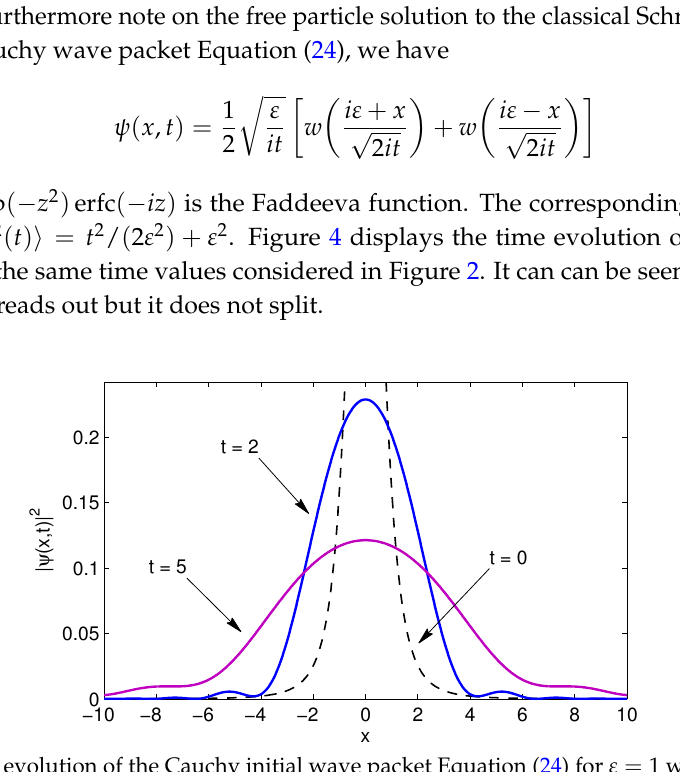
Figure 4. Time evolution of the Cauchy initial wave packet Equation (24) for ε = 1 within the classical quantum